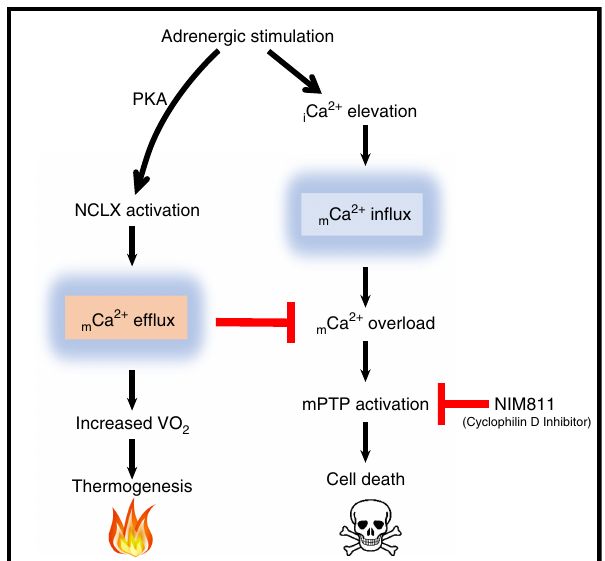
Fig. 8 Mechanism by which brown adipocytes avoid cell death during thermogenesis. Adrenergic stimulation of brown adipocytes leads to intracellular increase in Ca 2 + which can induce mitochondrial Ca 2 + overload and permeability transition. While in other cell types, such scenario will progress to apoptosis, in BA, adrenergic stimulation leads to activation of Ca 2 + extrusion through NCLX, thereby preventing permeability transition and cell death. Inhibition of permeability transition using the Cyclophilin D inhibitor, NIM811, can prevent cell death and restore function even in the absence of NCLX, and while Ca 2 + overload persists. i Ca 2 + , intracellular Ca 2 þ ; m Ca 2 þ , mitochondrial Ca 2 þ